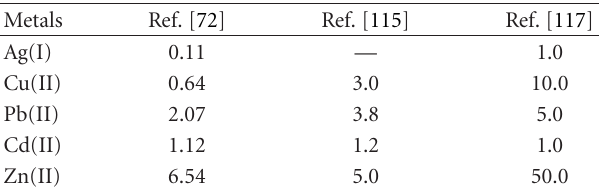
Table 2: Quantification limit (ppb) of di ff erent heavy metals for BDND electrodes using